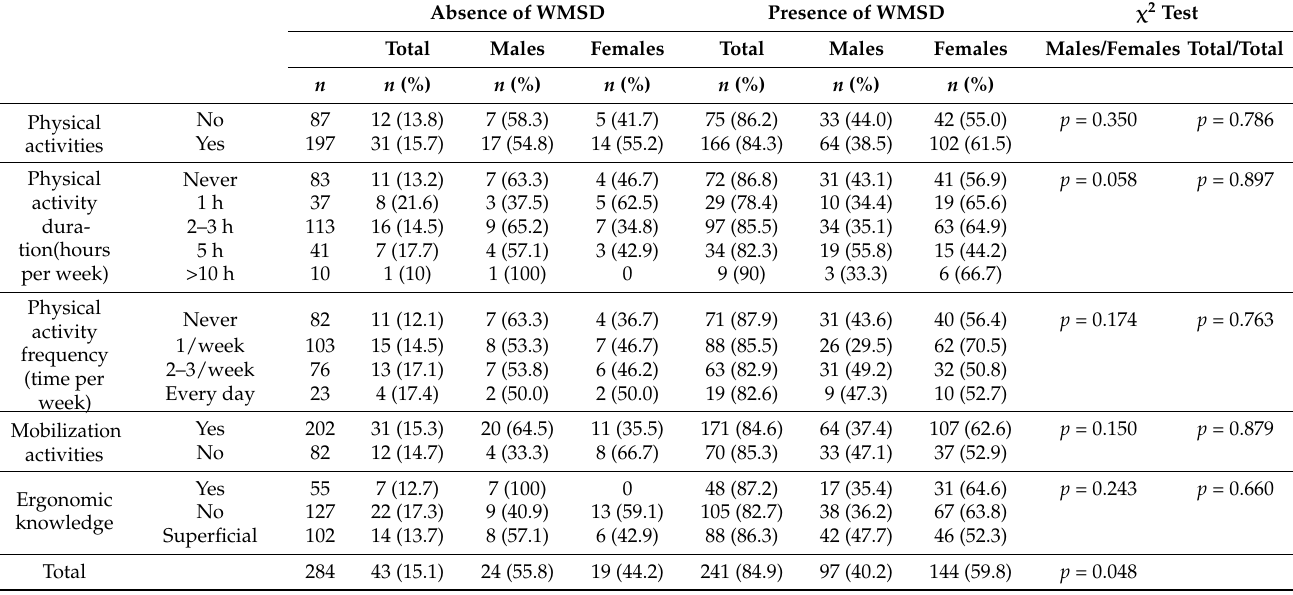
Table 4. WMSD in relation physical activity, their frequency and duration, mobilization exercises and knowledge of ergonomic guidelines (statistical significance for p < 0.05). All these parameters were not statistically significant ( p > 0.05).